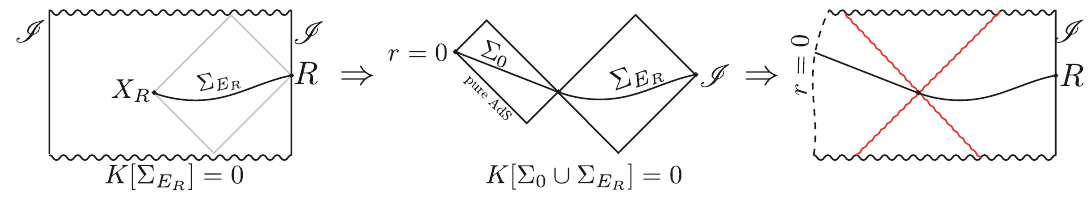
Figure 6 . Example of the proceedure used to build the simplest WCC respecting spherically symmetric spacetime (at time R ) containing the entanglement wedge E Cauchy slice Σ of an entanglement wedge E (left) is glued to a ball Σ E R R with extrinsic curvature K = 0 (center). Then the maximal Cauchy evolution of Σ ab the wanted spacetime (right). The red wiggly lines describe positive energy